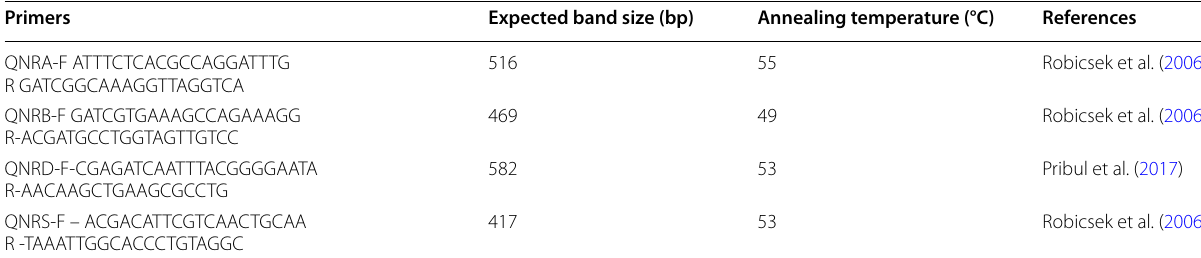
Table 1 Primers for Quinolone Resistant genes A, B, D and S Primers